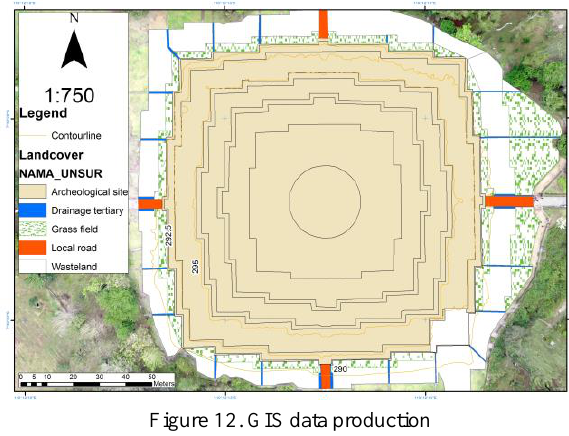
Figure 10. GCPs from VHRS